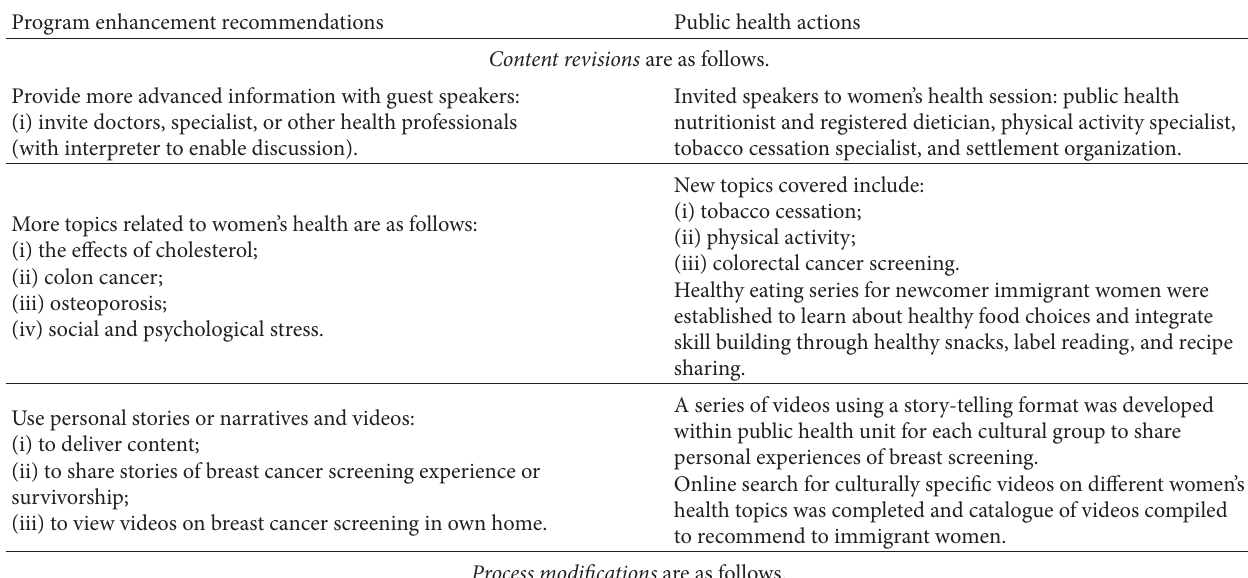
Table 3: Participatory action research